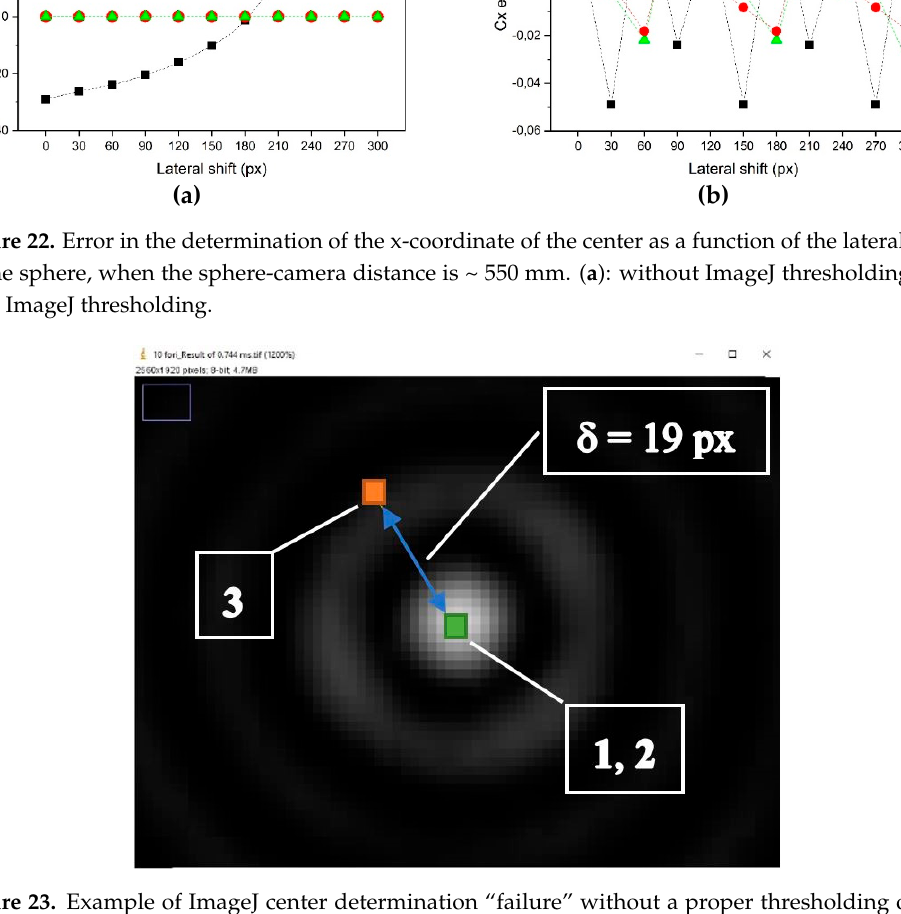
Figure 23. Example of ImageJ center determination “failure” without a proper thresholding of the image: nearly overlying labels ‘ 1 ’ and ‘ 2 ’, inside the central bright disc, show the centers found by VAR and FFT-based algorithms, while label ‘ 3 ’ shows the ImageJ result; the distance δ between the centers is ~42 μ m in this test configuration! (here the pixel size is 2.2 μ m).